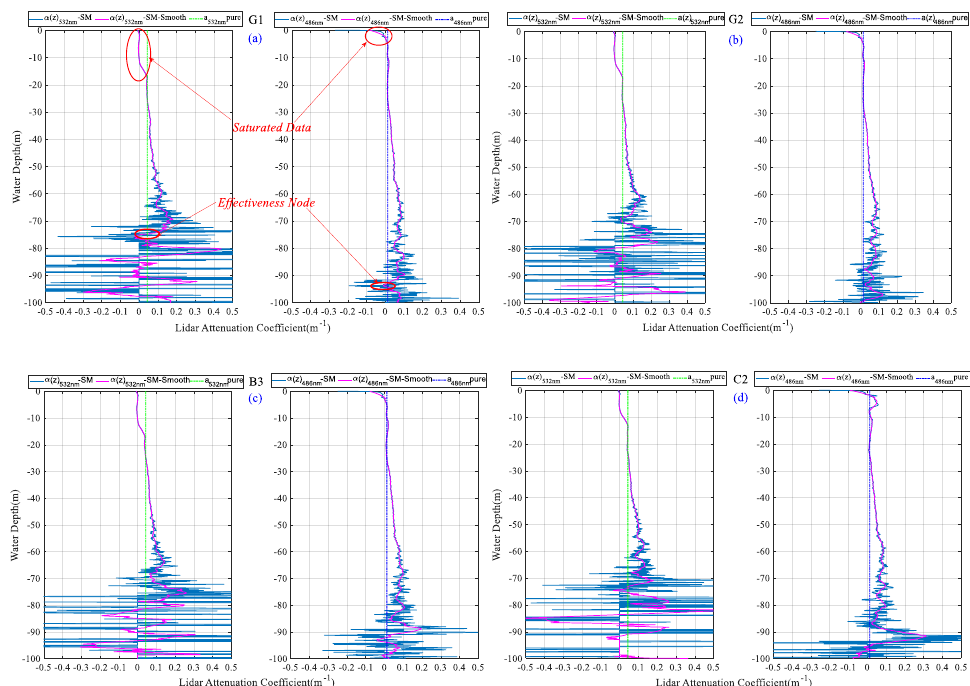
Figure 17. Distribution of lidar attenuation α ( z ) from G1 to C2. ( a ) Distribution of lidar attenuation at G1 ; ( b ) Distribution of lidar attenuation at G2 ; ( c ) Distribution of lidar attenuation at B3 ; ( d ) Distribution of lidar attenuation at C2 ; To enhance the stability of the inverted results, the range-corrected returning signals S (cid:48) were smoothed by applying a moving average with a 41-ns span. The magenta curves were obtained by a secondary smoothing of the inverse results using the Savity–Golay method with a 51-ns span.